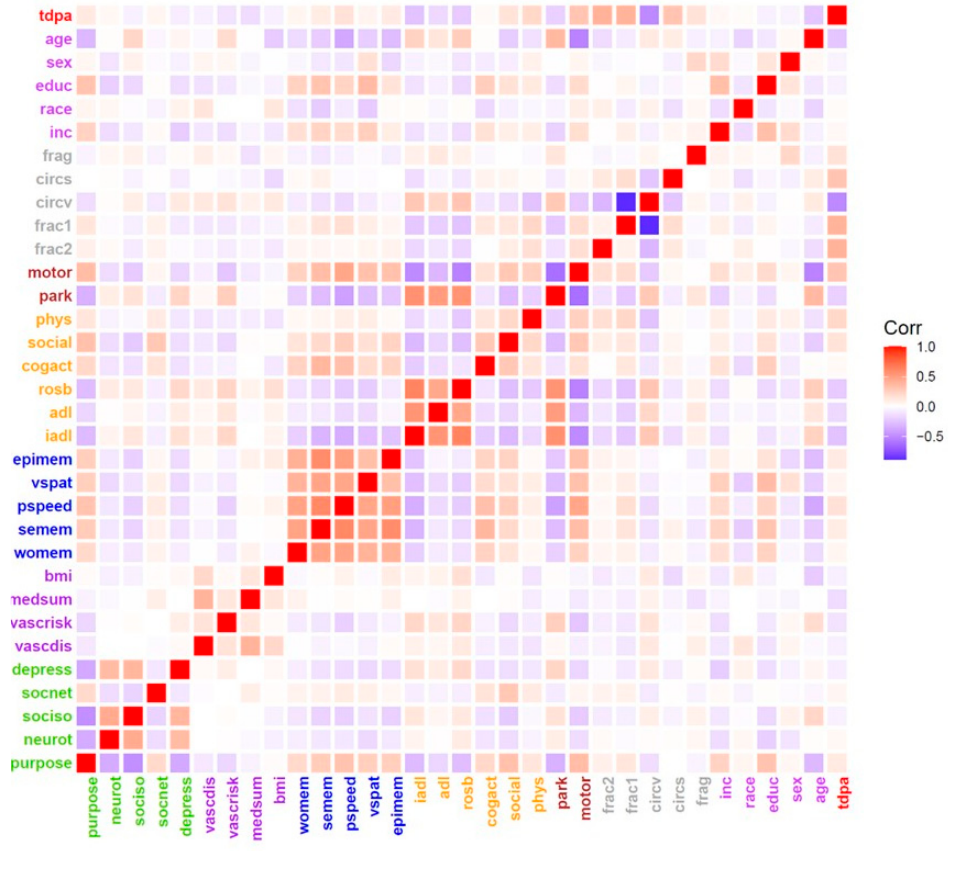
Figure 1. Baseline Correlations of Total Daily Physical Activity (TDPA) and Covariates *. *